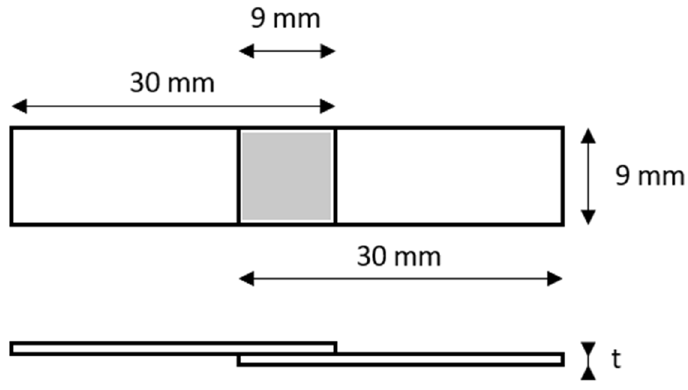
Figure 1. Weld configuration. Table 1. Nominal and measured mechanical properties of EN Cu-ETP material.